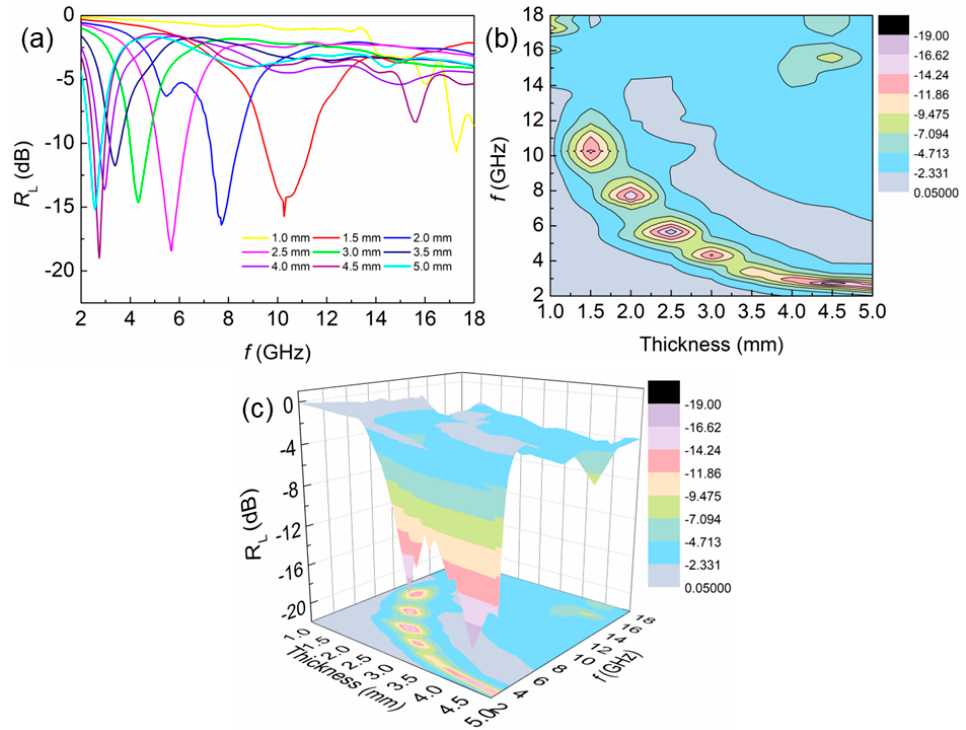
Figure 6. Frequency dependence of reflection loss and sample thickness of as–prepared FeSiBNi2 metallic microwires with a mass ratio of 50 wt.% with different thicknesses of composite at 2–18 GHz: ( a ) frequency dependence of R L curves; ( b ) 2D contour plots of thickness and reflection loss; ( c ) 3D variation diagram of reflection loss after fitting.